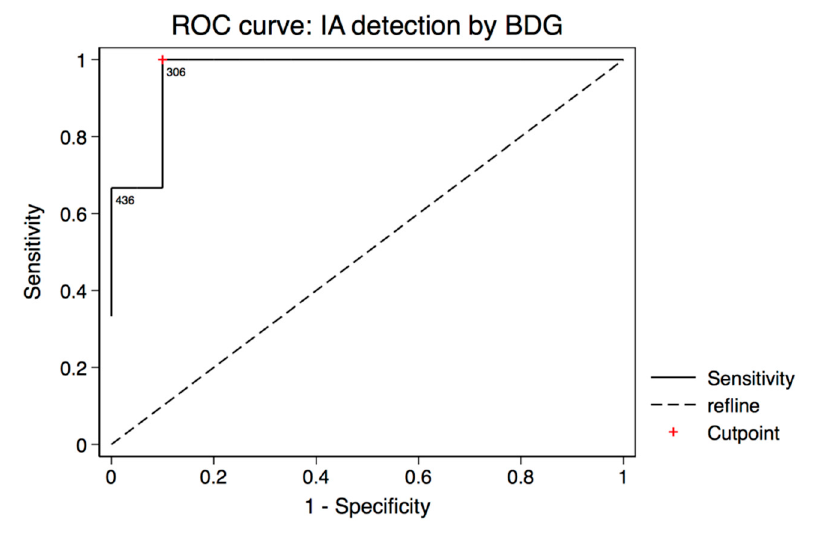
Figure 1. Receiver operating characteristic (ROC) curve analysis of BDG testing showing the optimal cutoff value of 306 pg/mL including probable IA cases and not classified patients as controls. Sensitivity was 100%, specificity was 90%, and the fraction of the correctly classified patients was 91%. The area under the ROC curve was 0.9667 (95% CI: 0.8874, 1). Table 5. Features of not classified patients with positive BDG testing. a: d, days in correlation to SCT; negative numbers indicate time before SCT. SC(T), stem cell